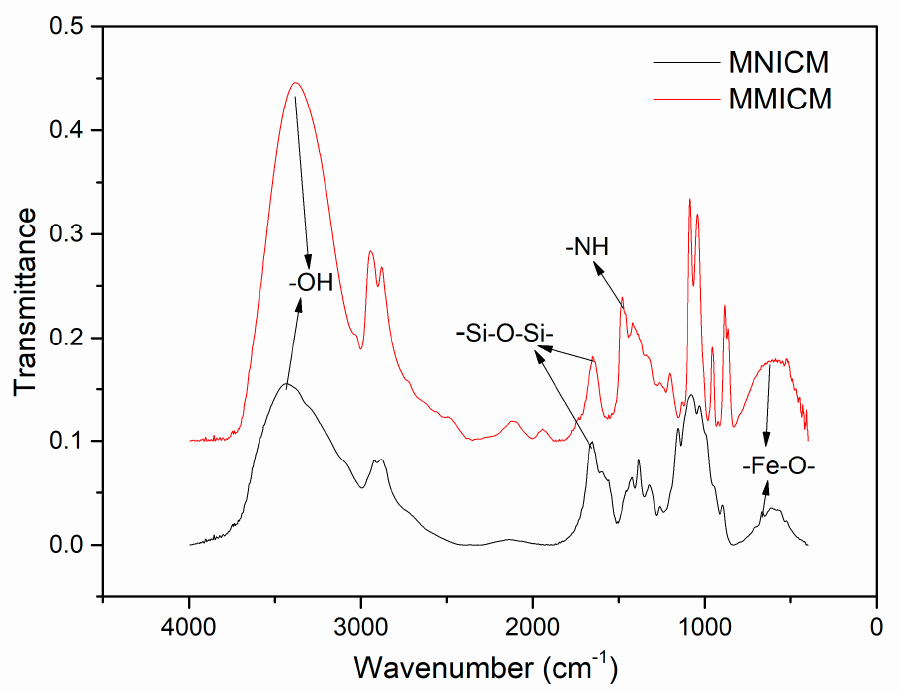
Figure 2. FT-IR spectra of the MNICM and MMICM. The morphologies and microstructures of the constructed MMICM and MNICM are clearly visualized by SEM in Figure 3. As presented here, the SEM micrographs of the MMICM (Figure 3b) showed a more particle-like structure, increasing the adsorption area and performance, compared with the MNICM (Figure 3a). These results demonstrated that the structure of MMICM is well maintained, showing uniform particle size and good